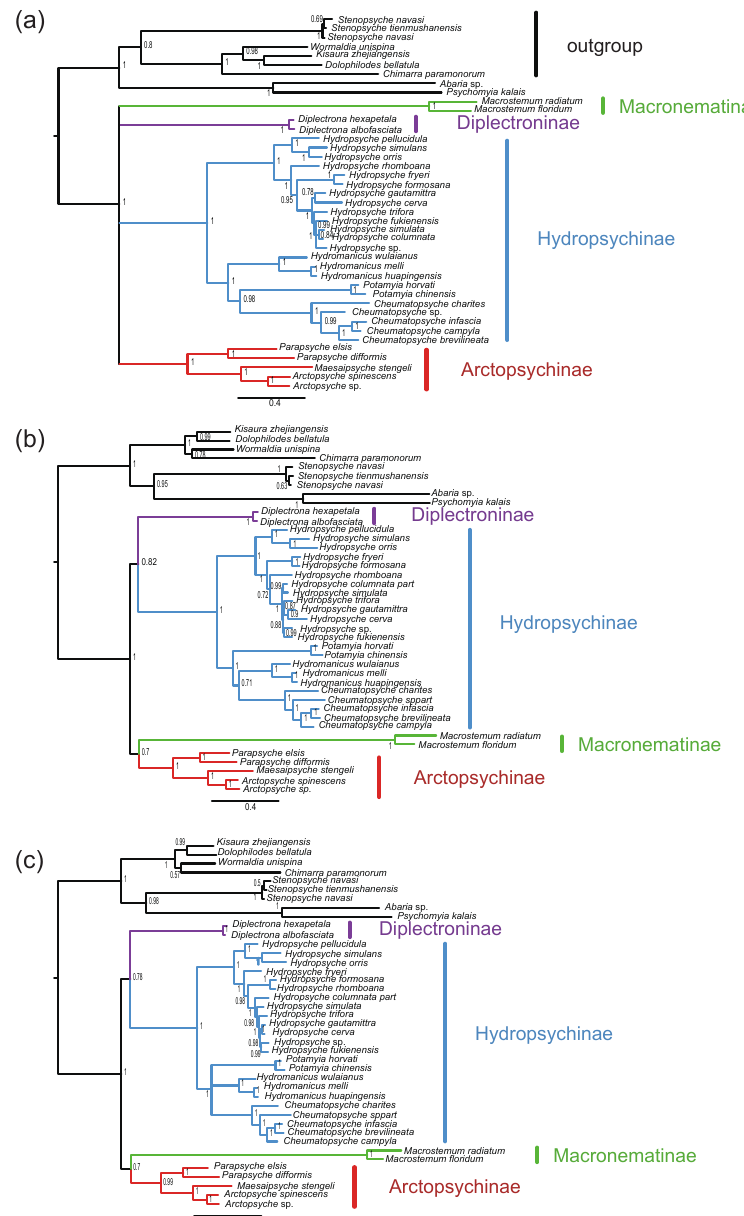
Figure 5. Phylogeny of Hydropsychidae based on three datasets using GTR+CAT mode in phylobayes. Node supports are Bayesian posterior probabilities. ( a ) PCGs_faa dataset; ( b ) PCG12_fna dataset; ( c ) PCG12_rrna